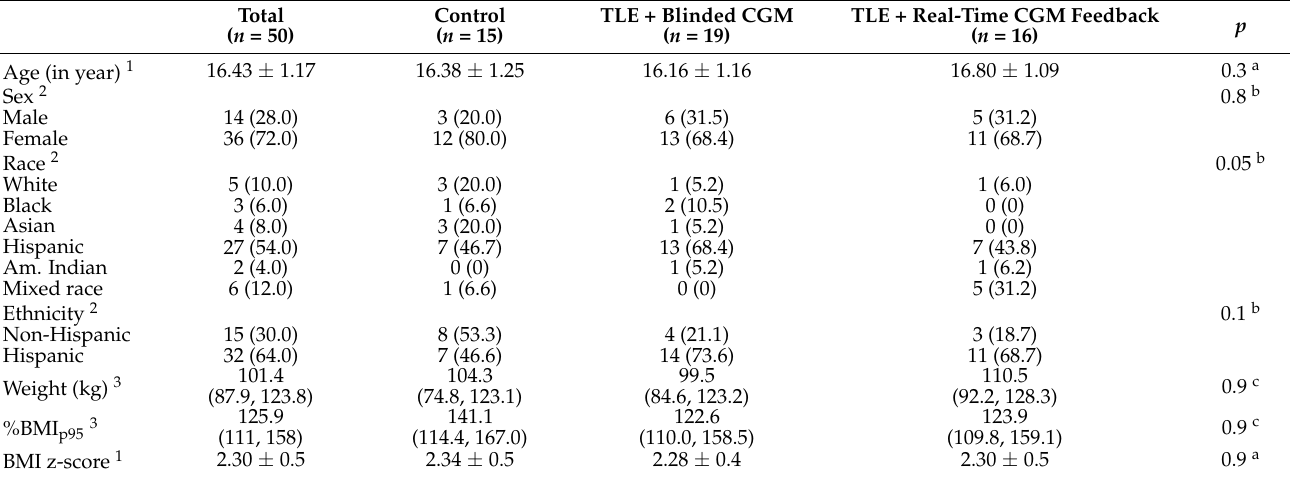
Table 1. Demographic characteristics and baseline anthropometrics.